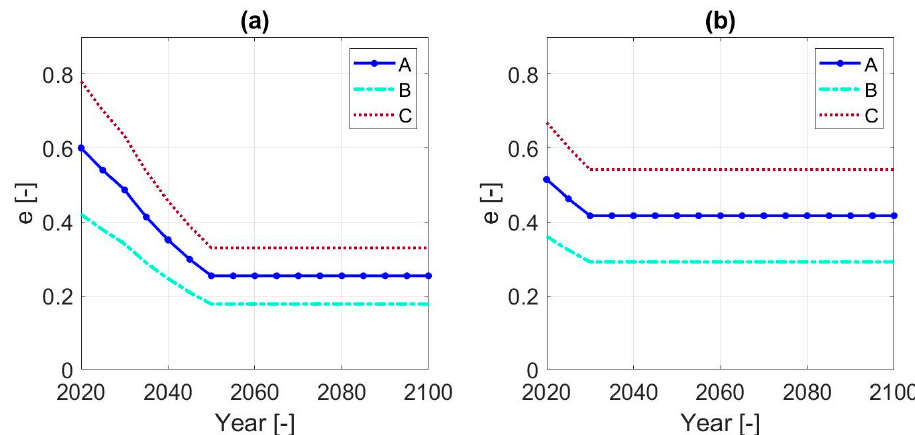
Figure 6. ETM elasticity trends for ( a ) gross domestic product and ( b ) population-associated demand categories [10] during the ETM time horizon, for the different storylines.